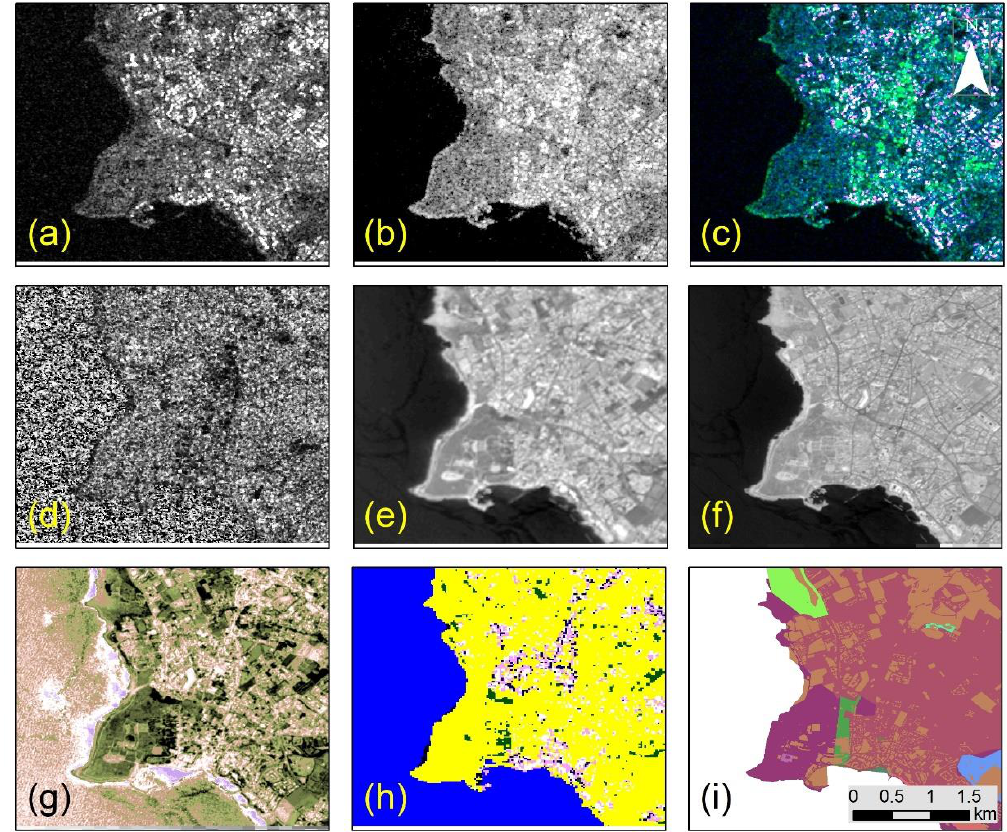
Figure 3. Sentinel-1 and Sentinel-2 datasets and ready products downloaded from the EO Browser of the Sentinel Hub Service used in this study. ( a ) orthorectified Sentinel-1, VH polarization, gamma 0, ( b ) orthorectified Sentinel-1, VV polarisation, gamma 0, ( c ) Sentinel-1 Synthetic Aperture Radar (SAR) urban visualization product, ( d ) Sentinel-1 Radar Vegetation Index, ( e ) Sentinel-2, Bottom-of-Atmosphere (BOA) Band 5, ( f ) Sentinel-2, Bottom-of-Atmosphere (BOA) Band 8, ( g ) Sentinel-2, Normalized Difference Vegetation Index (NDVI), ( h ) Sentinel-2, Scene Classification product, and ( i ) the OpenStreetMap vector data of the area. The scale for all sub-figures is shown in the right bottom part of the Figure 3.